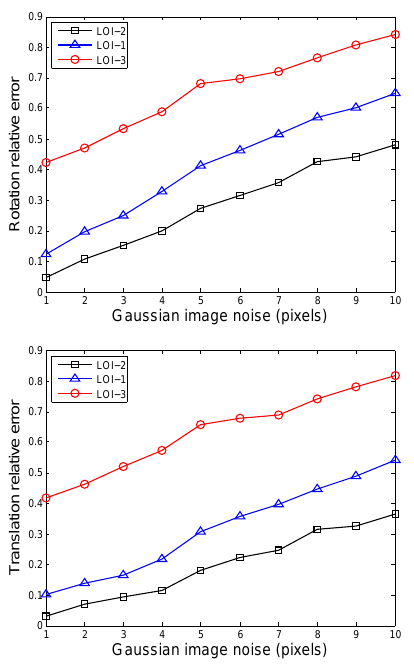
Figure 3: Relative rotation and translation error as a function of image noise when the number of lines is fixed to be 8. Fig. 4 plots the errors as the function of the number of 3D object